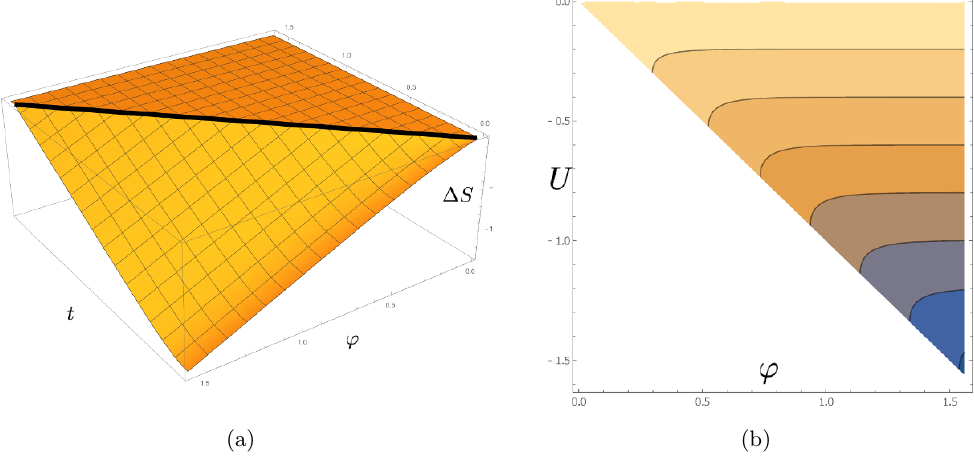
Figure 17 . (a) three-dimensional picture of entanglement spreading in case of symmetric intervals. The horizontal plateau represents the equilibrium regime. (b) density plot of non-equilibrium HEE as a function of ’ = (cid:1) ’ and U = t (cid:0) ’ , with R = 5. The horizontal lines signify the disappearance 2 of dependence of ’ , which is the memory loss